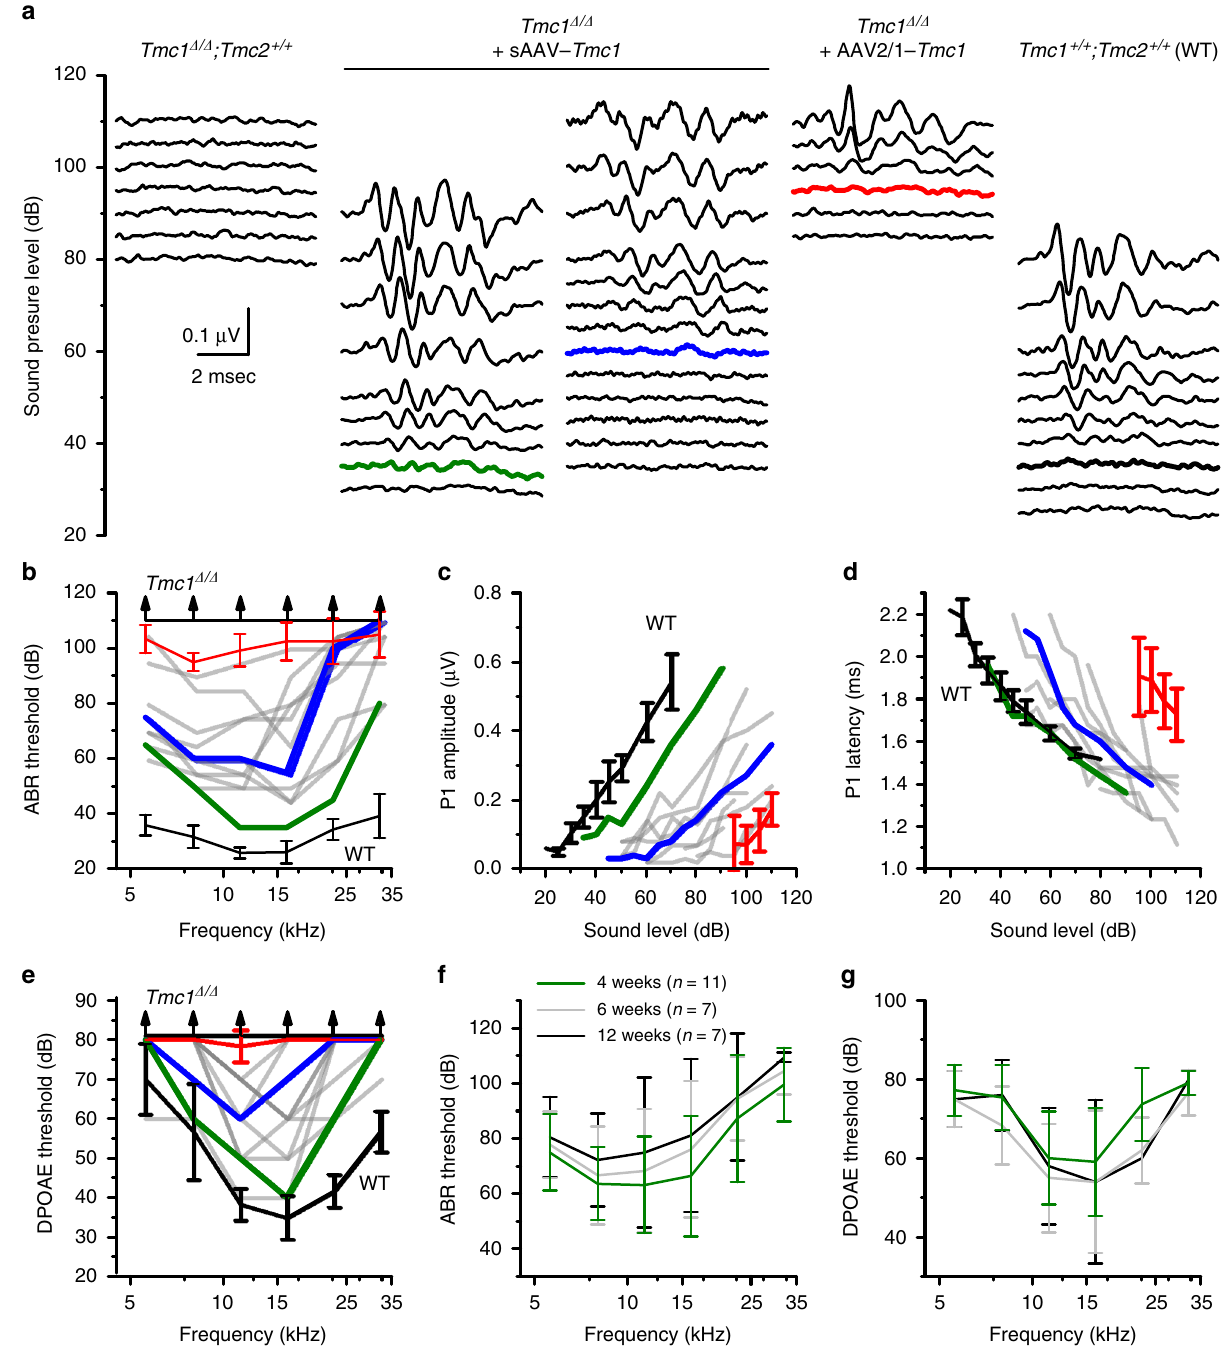
Fig. 2 sAAV- Tmc1 restores ABRs and DPOAEs in Tmc1 Δ / Δ mice. a Families of ABR waveforms recorded at P28-P30 from uninjected Tmc1 Δ / Δ mouse (left) and from Tmc1 Δ / Δ mice injected with sAAV- Tmc1 or AAV2/1- Tmc1 and one WT control, as indicated above. ABRs were recorded using 11.3-kHz tone bursts at sound pressure levels increasing by 5-dB until peak amplitudes reached 0.55 μ V. Thresholds determined by the presence of Peak 1 and is indicated by colored traces. Scale bar applies to all families. b ABR thresholds plotted as a function of stimulus frequency for eleven Tmc1 Δ / Δ mice injected with sAAV- Tmc1 tested at P28-P30 (gray traces). Best (green), and median (blue) recovery are indicated. Black lines show mean ± S.D. ( n = 6 mice) for WT and Tmc1 Δ / Δ uninjected mice as indicated. Red line shows mean ± S.D. ( n = 6 mice) for Tmc1 Δ / Δ injected with AAV2/1- Tmc1 . c Peak 1 amplitudes measured from 11.3-kHz ABR waveforms, as shown in a , for eleven Tmc1 Δ / Δ mice injected with sAAV- Tmc1 . Colors correspond to conditions indicated in b . d Peak 1 latencies measured from 11.3-kHz ABR waveforms, as shown in a for eleven Tmc1 Δ / Δ mice injected with sAAV- Tmc1 . Colors correspond to conditions indicated in b . e DPOAE thresholds plotted as a function of stimulus frequency for eleven Tmc1 Δ / Δ mice injected with sAAV- Tmc1 tested at P28-P30. Colors correspond to conditions indicated in b . f Mean± S.D. ( n = number of mice) ABR thresholds plotted as a function of stimulus frequency for Tmc1 Δ / Δ mice injected with sAAV- Tmc1 at P1 tested at 4, 6, and 12 weeks. g Mean ± S.D. DPOAE thresholds plotted as a function of stimulus frequency for the same Tmc1 Δ / Δ mice shown in panel G injected with sAAV-